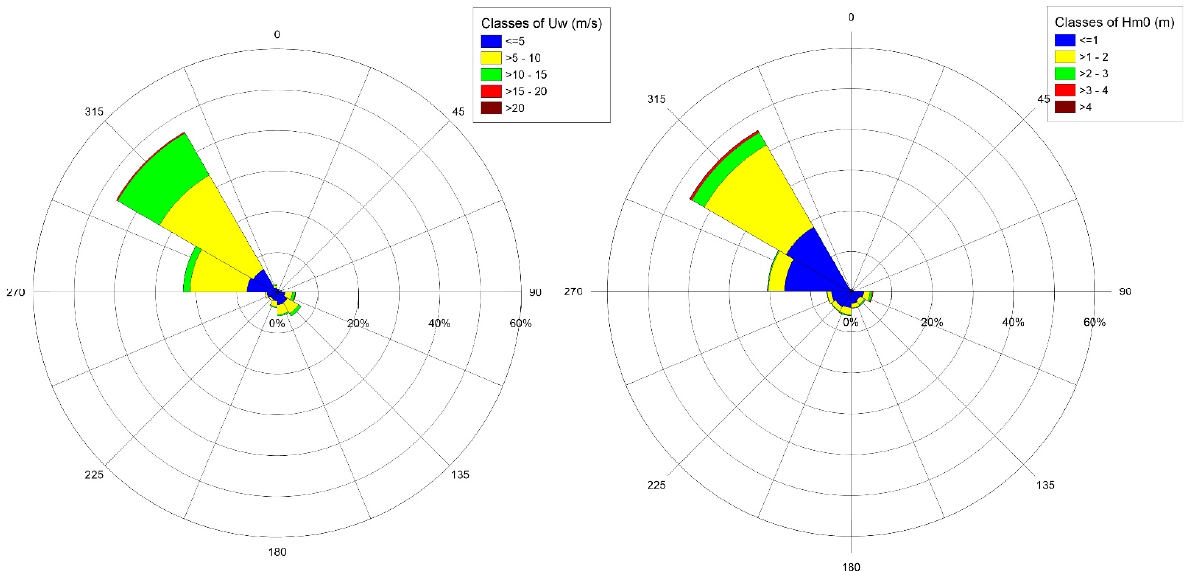
Figure 4. Rose diagram of wind velocity Uw ( left ) and significant wave height Hm0 ( right ) in the time period of 1995 to 2004, as extracted from Wind and Wave Atlas of the Hellenic Seas [28]. Figure created in Grapher 9.